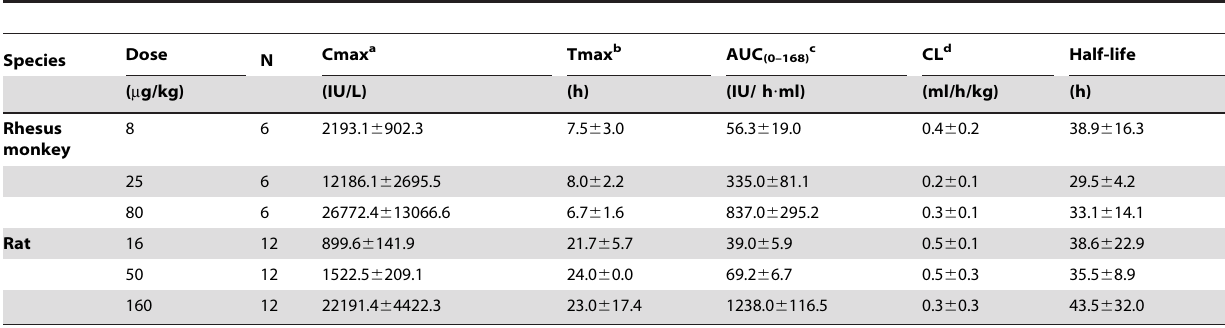
Table 1. Pharmacokinetic parameters of rhEPO-Fc following single subcutaneous injection in rhesus monkeys and rats.